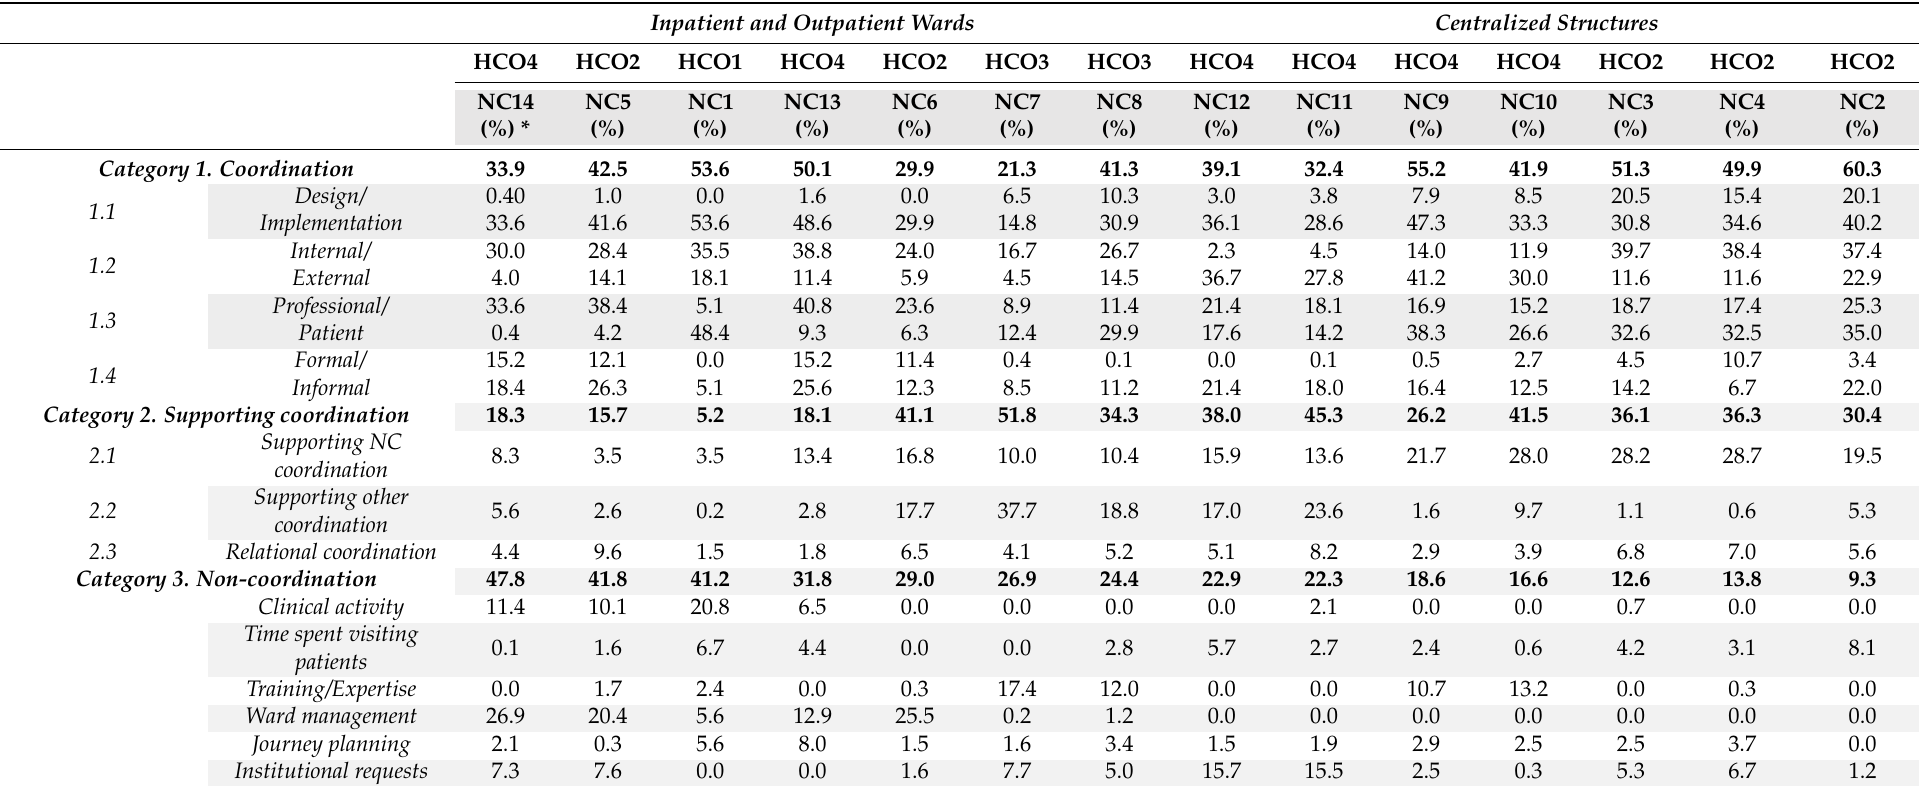
Table 3. Comparative analysis of NC activity in centralized structures versus NC activity in inpatient and outpatient wards. The APANCO framework was used to analyze NC work content.